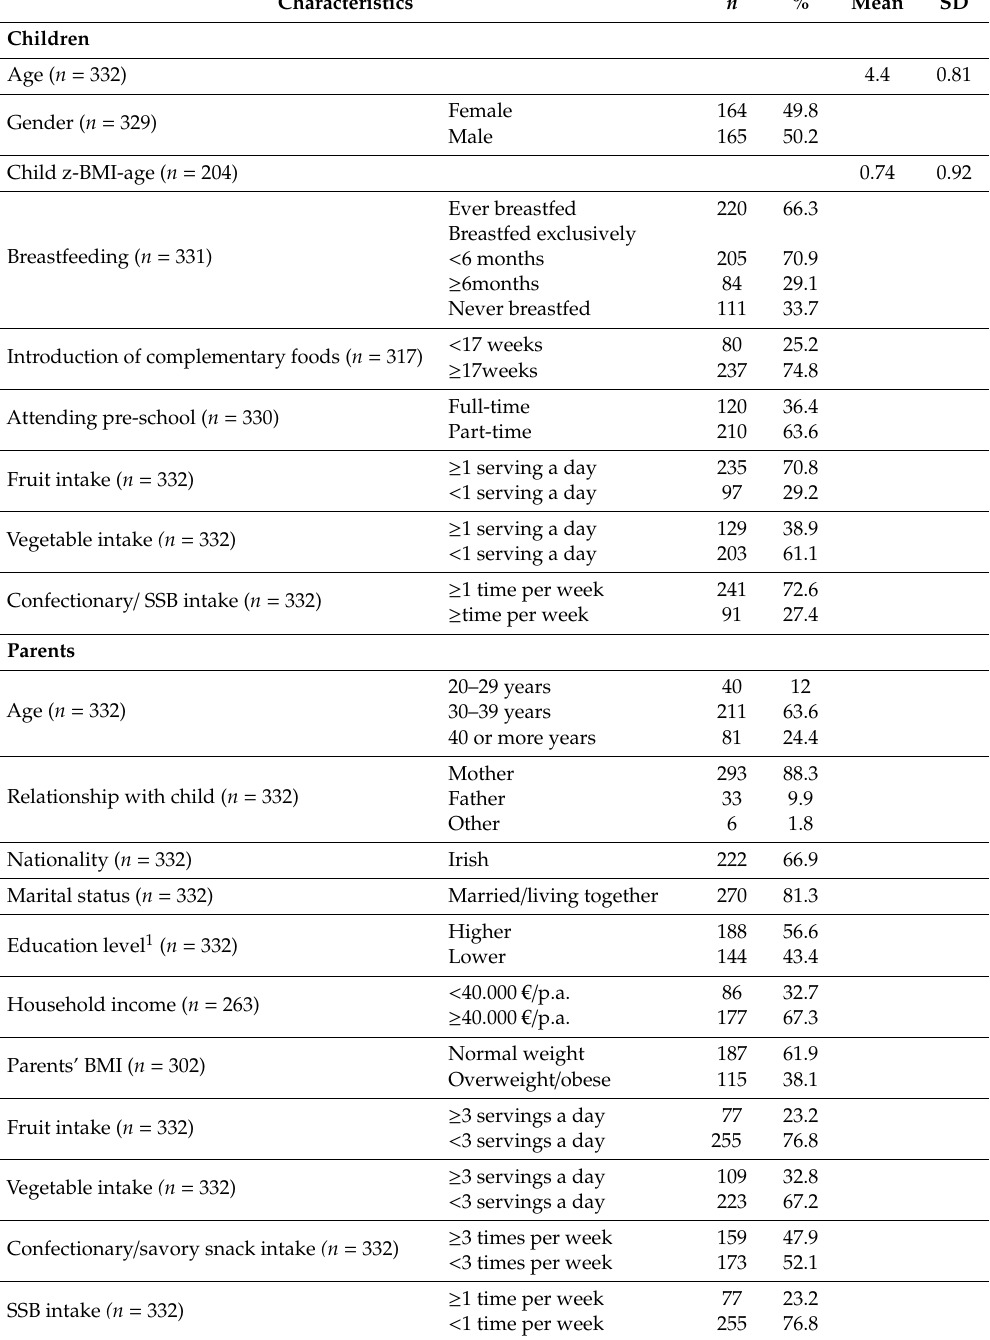
Table 1. Characteristics of